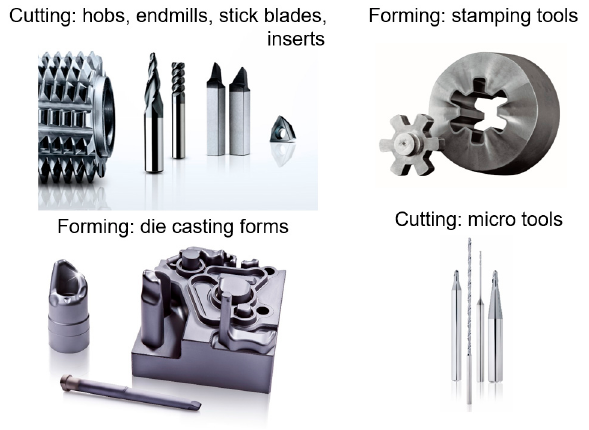
Figure 29. Selected tool applications for AlCr-based coatings, courtesy of Oerlikon 29